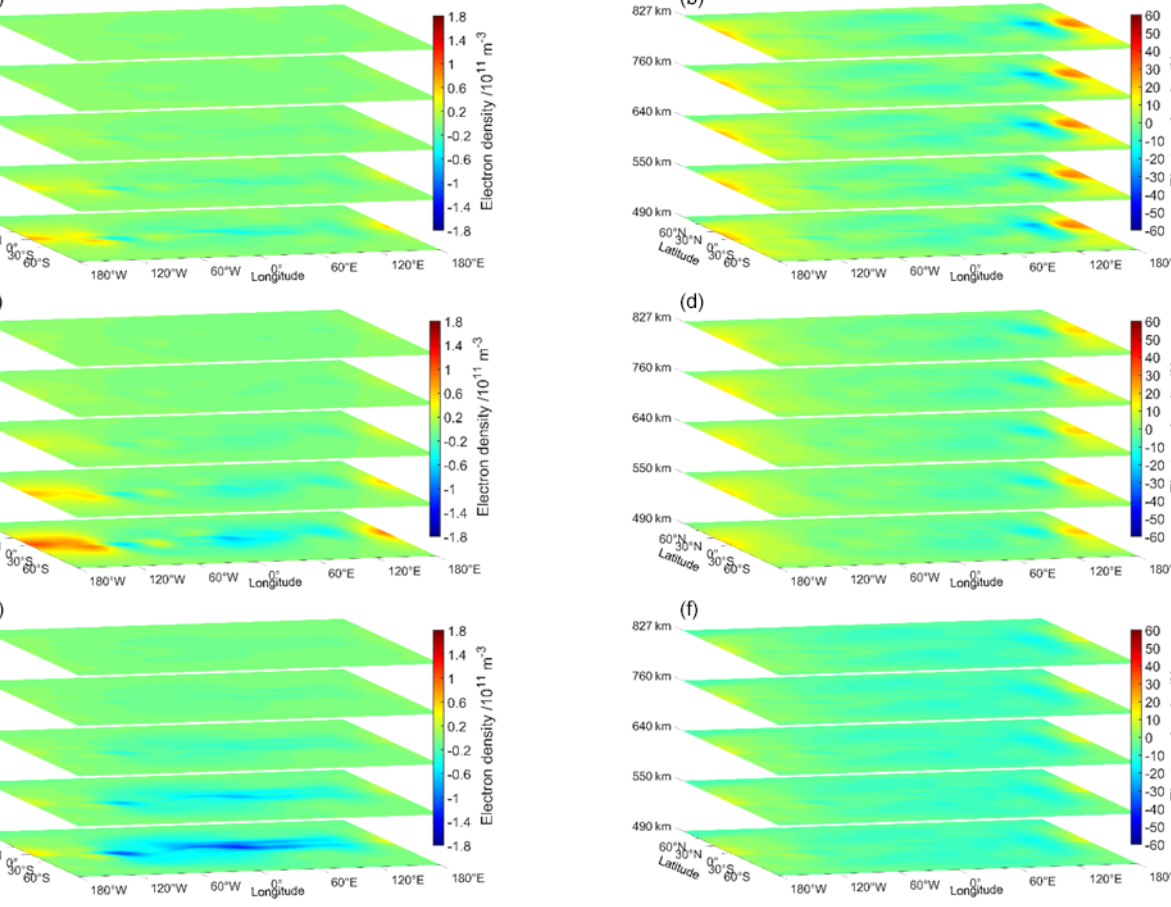
Figure 7. (a, c, e) Differences between the forecasted and analysed electron densities, represented by layers at different heights between 490 and 827km. (b, d, f) Differences in percent. (a, b) Method rotation with exponential decay. (c, d) Rotation. (e, f) Exponential decay.